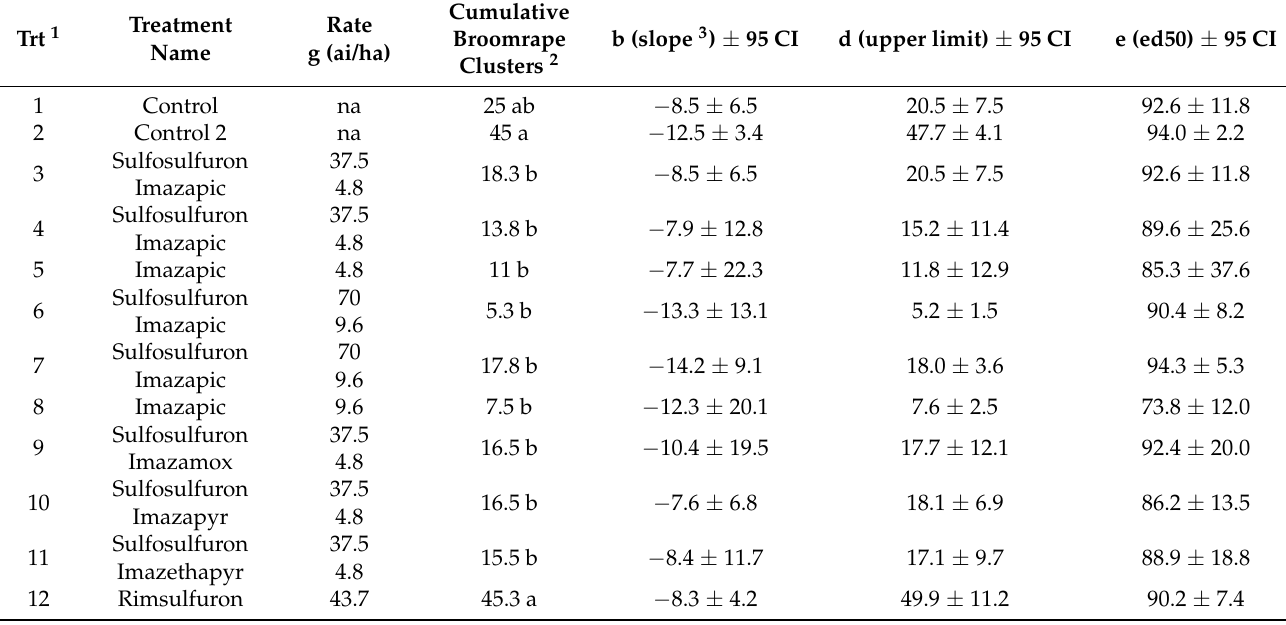
Table 5. Effect of herbicide treatments on broomrape cluster number and predicted value of broomrape emergence in a tomato field trial from a 3-parameter log logistic model using drc package in